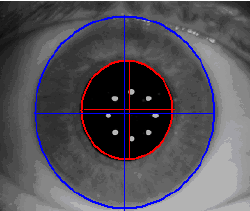
Figure 5. Pupil and limbus boundary recognition of the reference image .